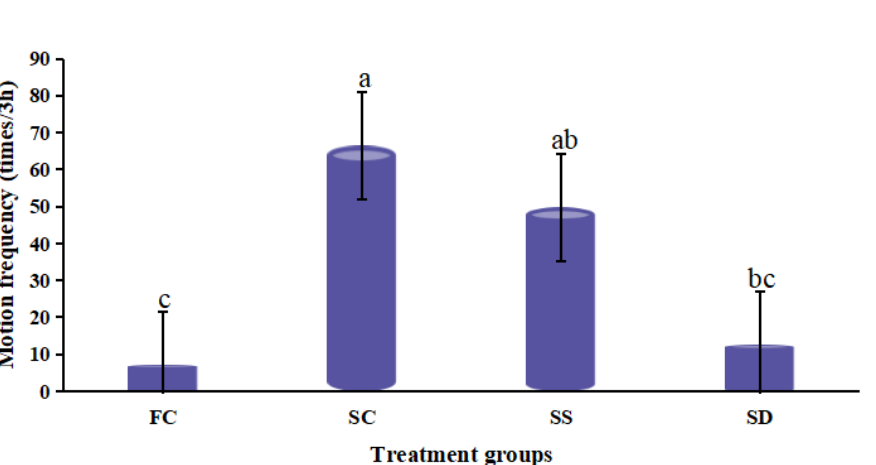
Figure 4. Cleaning of antennae in Eriocheir sinensis during 3 h exposure in four treatment groups (FC: freshwater control group; SC: salinity control group; SS: salinity surge group; SD: salinity dip group). Bars with the same lowercase letters on the top indicate insignificant differences ( p > 0.05), and bars with different letters on the top indicate significant differences ( p < 0.05).